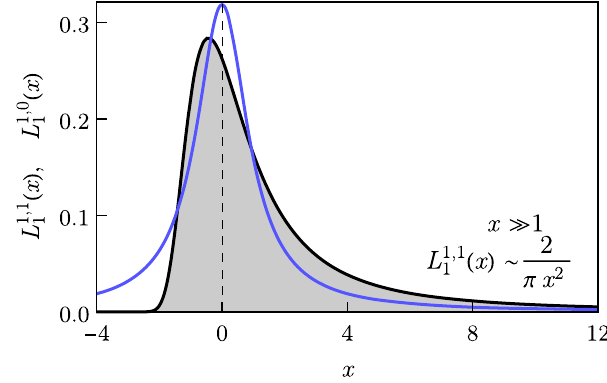
FIG. 15. The black solid line shows the plot of the Levy alpha- stable distribution L C; β α ð x Þ [33] with tail index α ¼ 1 , asymmetry parameter β ¼ 1 , and unit scale parameter C ¼ 1 . The inset shows asymptotic behavior of the distribution at large positive x . At − x ≫ 1 , the function decays steeply as a double exponential, log L 1 ; 1 1 ð x Þ ∝ − exp ½ − ð π = 2 Þ x (cid:2) . The blue line shows the